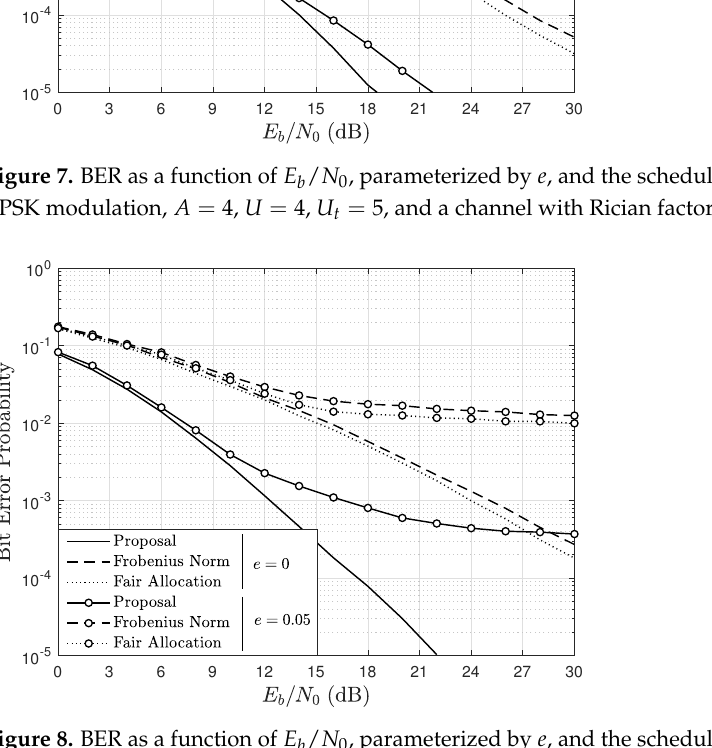
Figure 8. BER as a function of E b / N 0 , parameterized by e , and the scheduling algorithm considering 16-QAM, A = 4, U = 4, U t = 5, and a channel with Rician factor K =